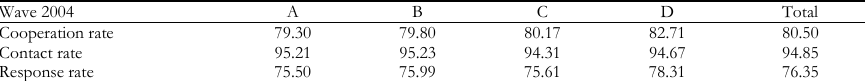
EU-SILC cross-sectional and longitudinal samples: synthetic quality indicators – wave 2004